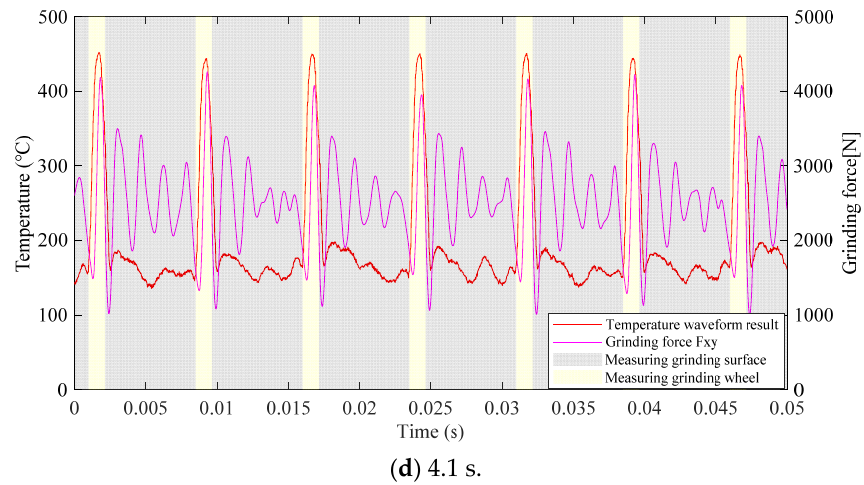
Figure 20. Transition of temperature and grinding force (2 path).